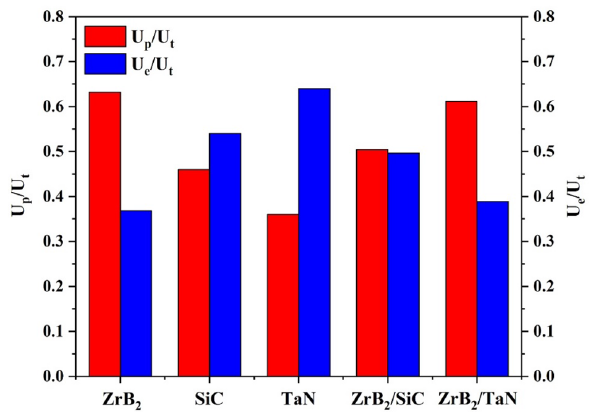
Figure 9. Plasticity index and elastic recovery of different phases in ZrB 2 -SiC-TaN ceramic.